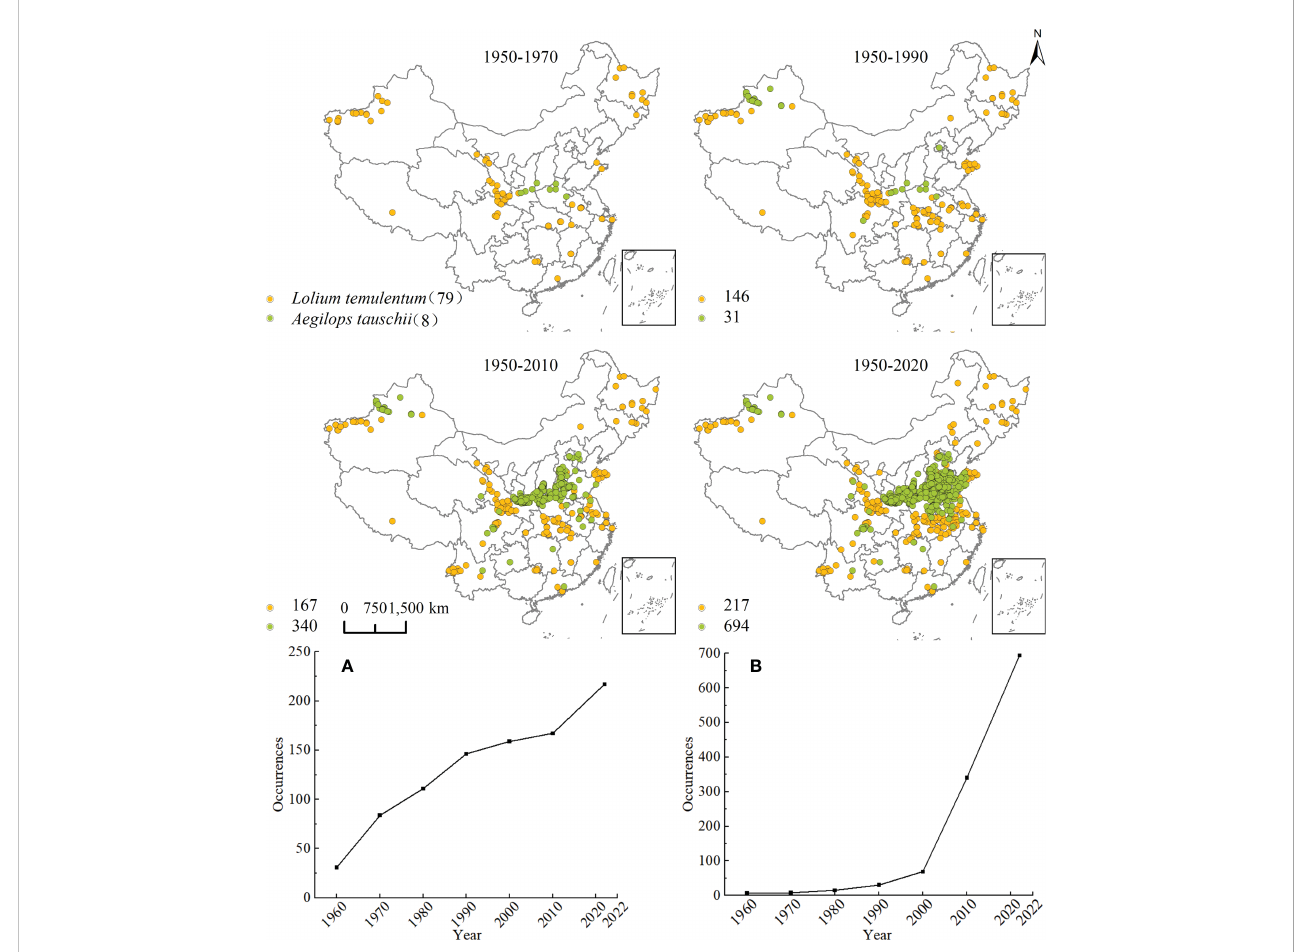
FIGURE 2 Historical reconstruction of the expansion process and increased species occurrence of (A) Lolium temulentum and (B) Aegilops tauschii from 1950 to